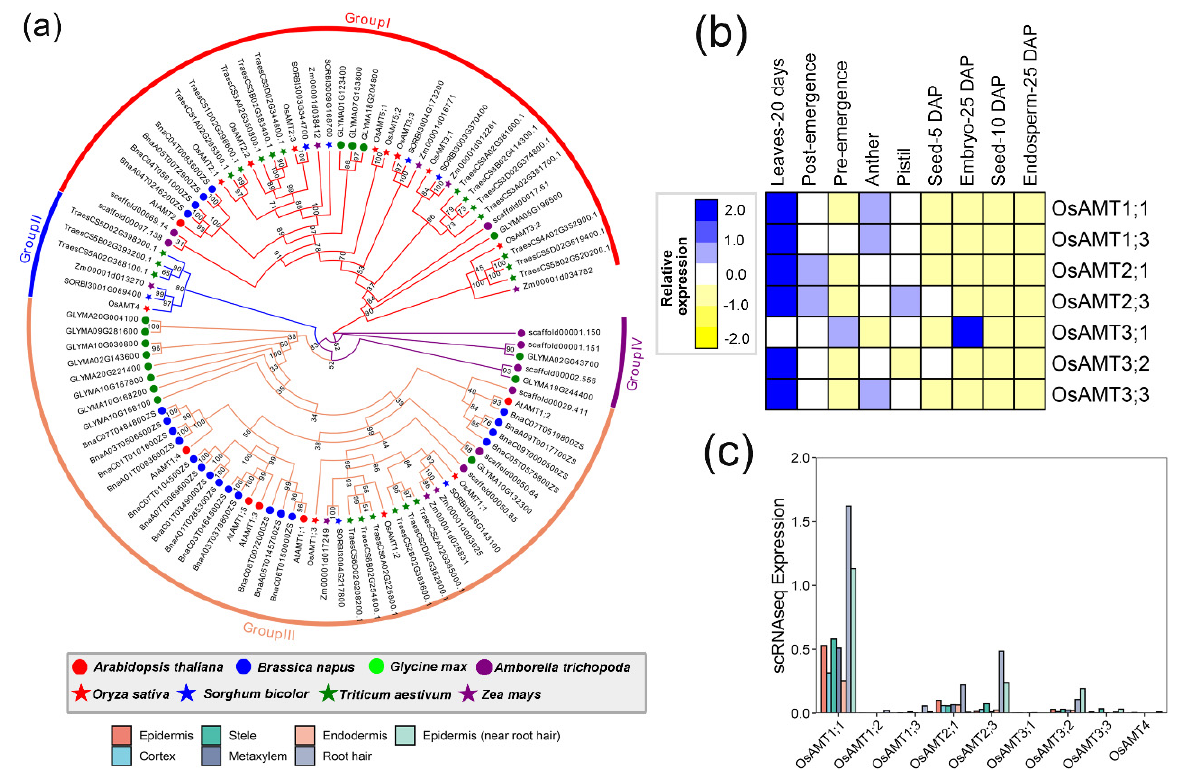
Figure 4. The phylogenetic analysis and expression pattern of AMT superfamily. ( a ) represents the phylogenetic trees of the GDH superfamily. The genes from the same cluster were defined as the same group. Based on the branch, the whole members were classified into four groups. ( b ) indicates the expression heatmap of the AMT superfamily, and ( c ) represents the expression of the AMT superfamily through the single-cell transcriptome data of roots in rice.